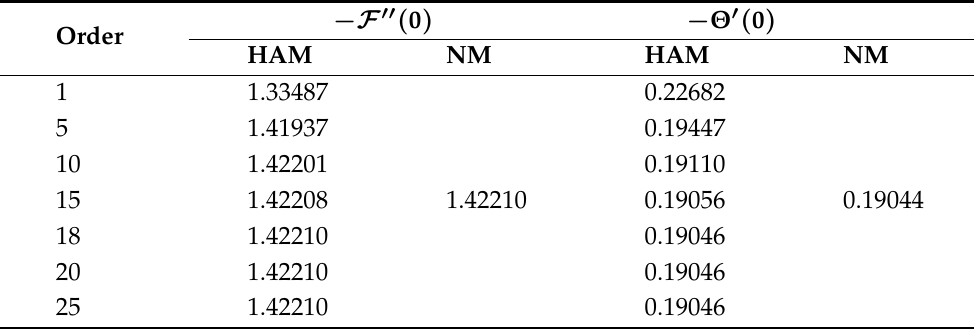
Table 4. HAM order and numerical value of Al 2 O 3